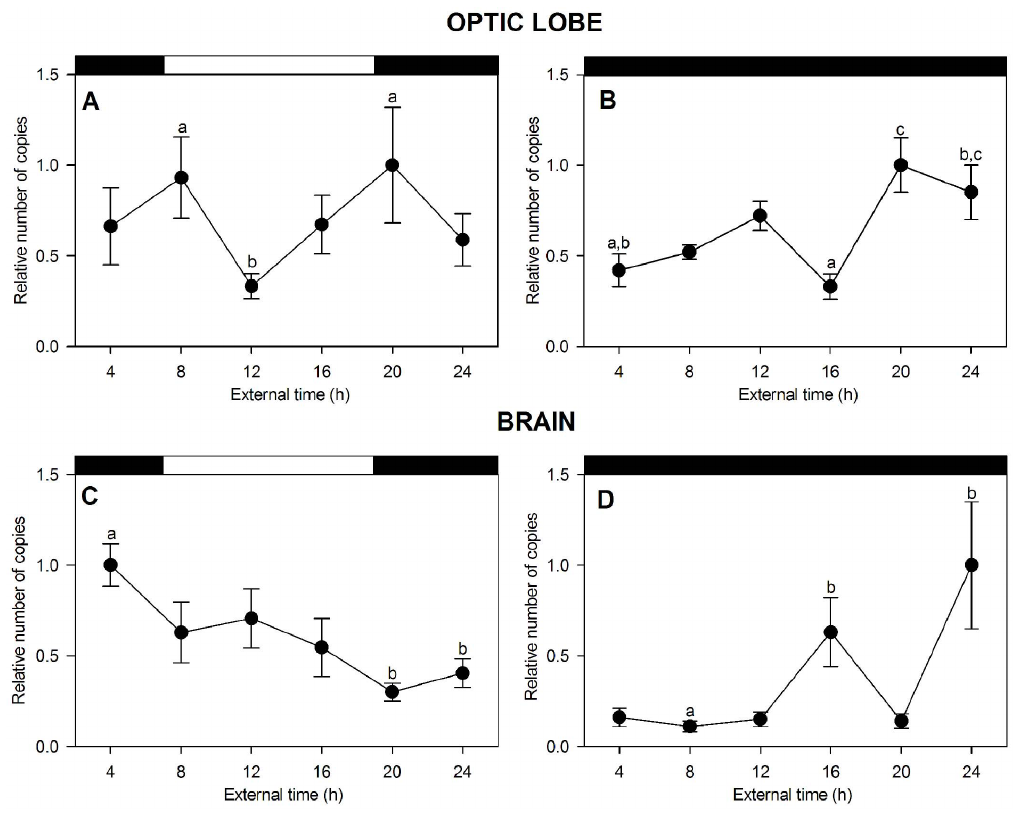
Figure 2. CHH mRNA levels daily and circadian oscillations in eyestalk and brain of P.clarkii. Chronograms showing rhythmic CHH mRNA expression in the optic lobe (A, B) and brain (C, D) under 12:12 light–dark cycles and continuous darkness. Data are the mean 6 standard error (SE) (n=6). The results are expressed relative to the highest level of expression in each graph. The upper black and white bars in each graph denote the light and dark phases. Different letters above some time points represent statistically significant differences (post hoc analysis, LSD); please see the text for the explanation.